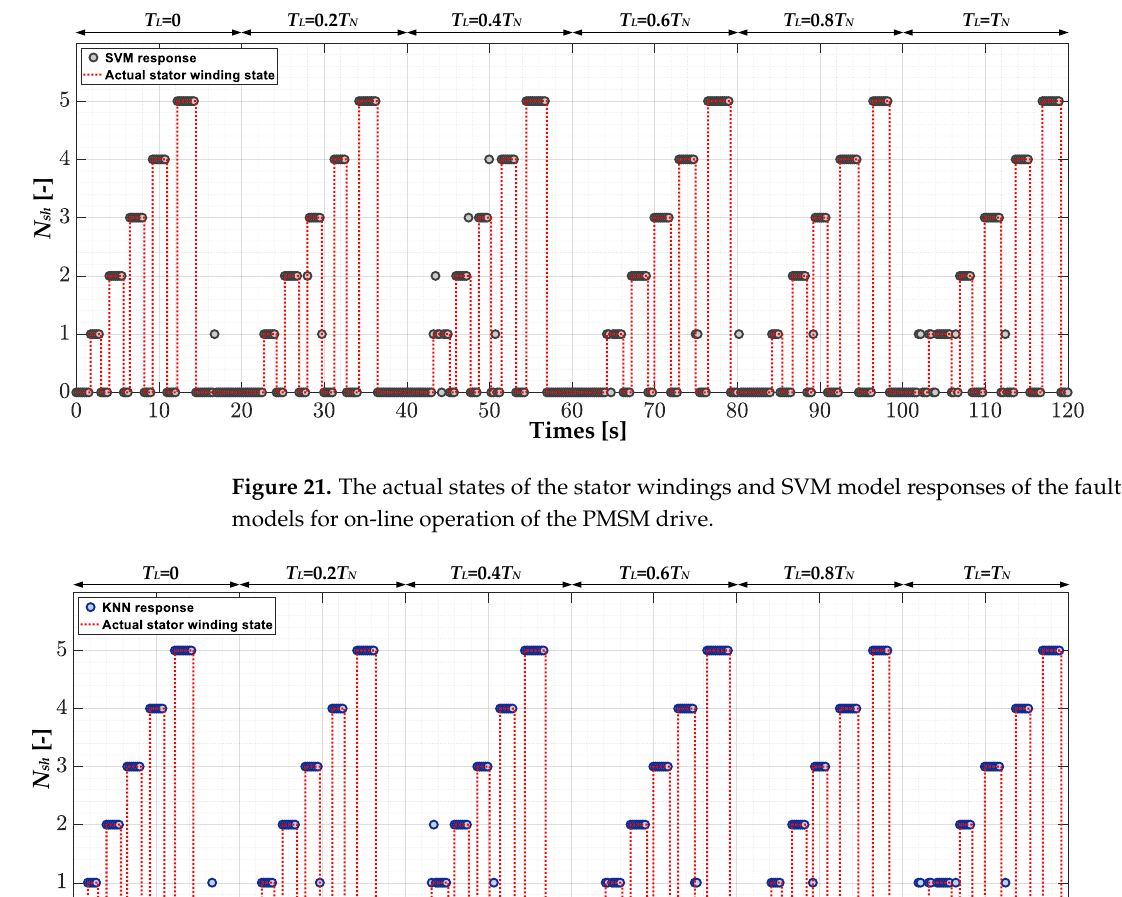
Figure 20. The actual states of the stator windings and MLP model responses of the fault classifier models for on-line operation of the PMSM drive.